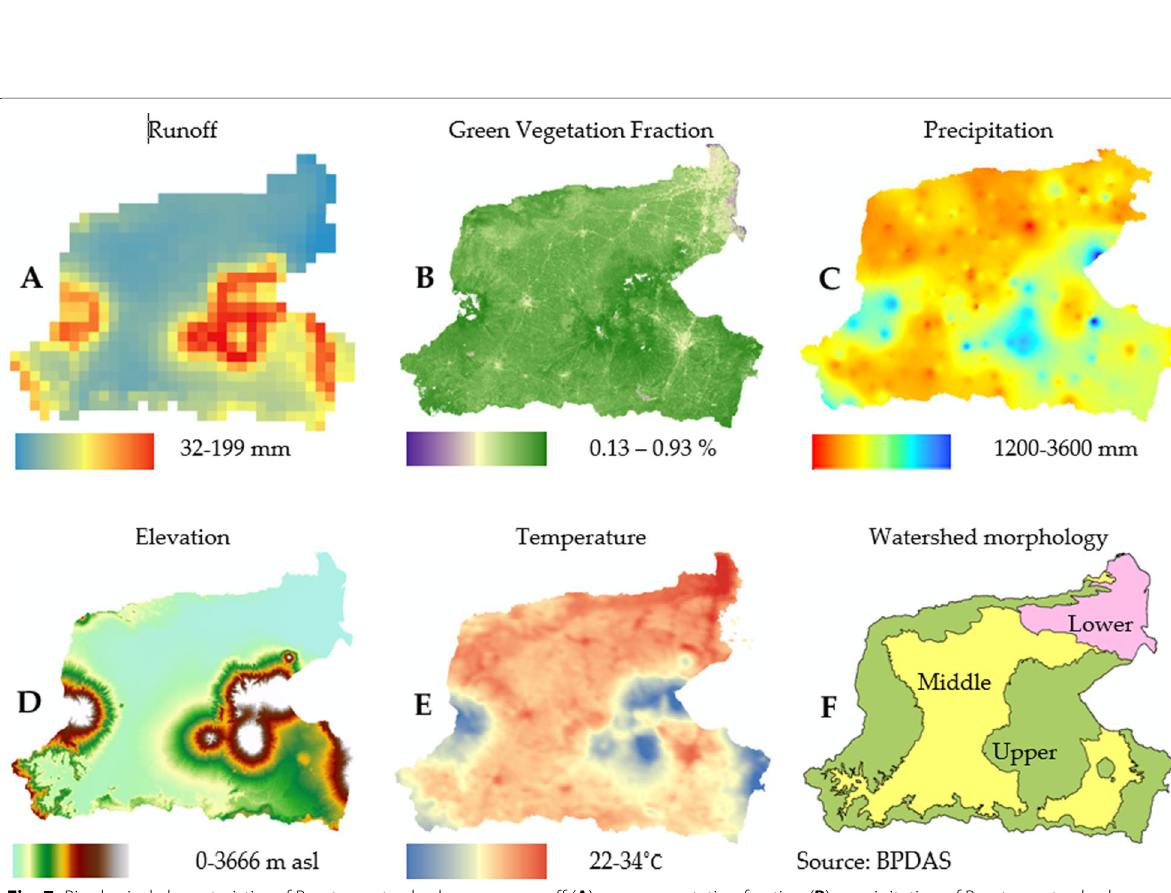
Fig. 7 Biophysical characteristics of Brantas watershed: average runoff ( A ), green vegetation fraction ( B ), precipitation of Brantas watershed 2001–2020 ( C ), elevation ( D ), temperature ( F ), and watershed morphology ( F